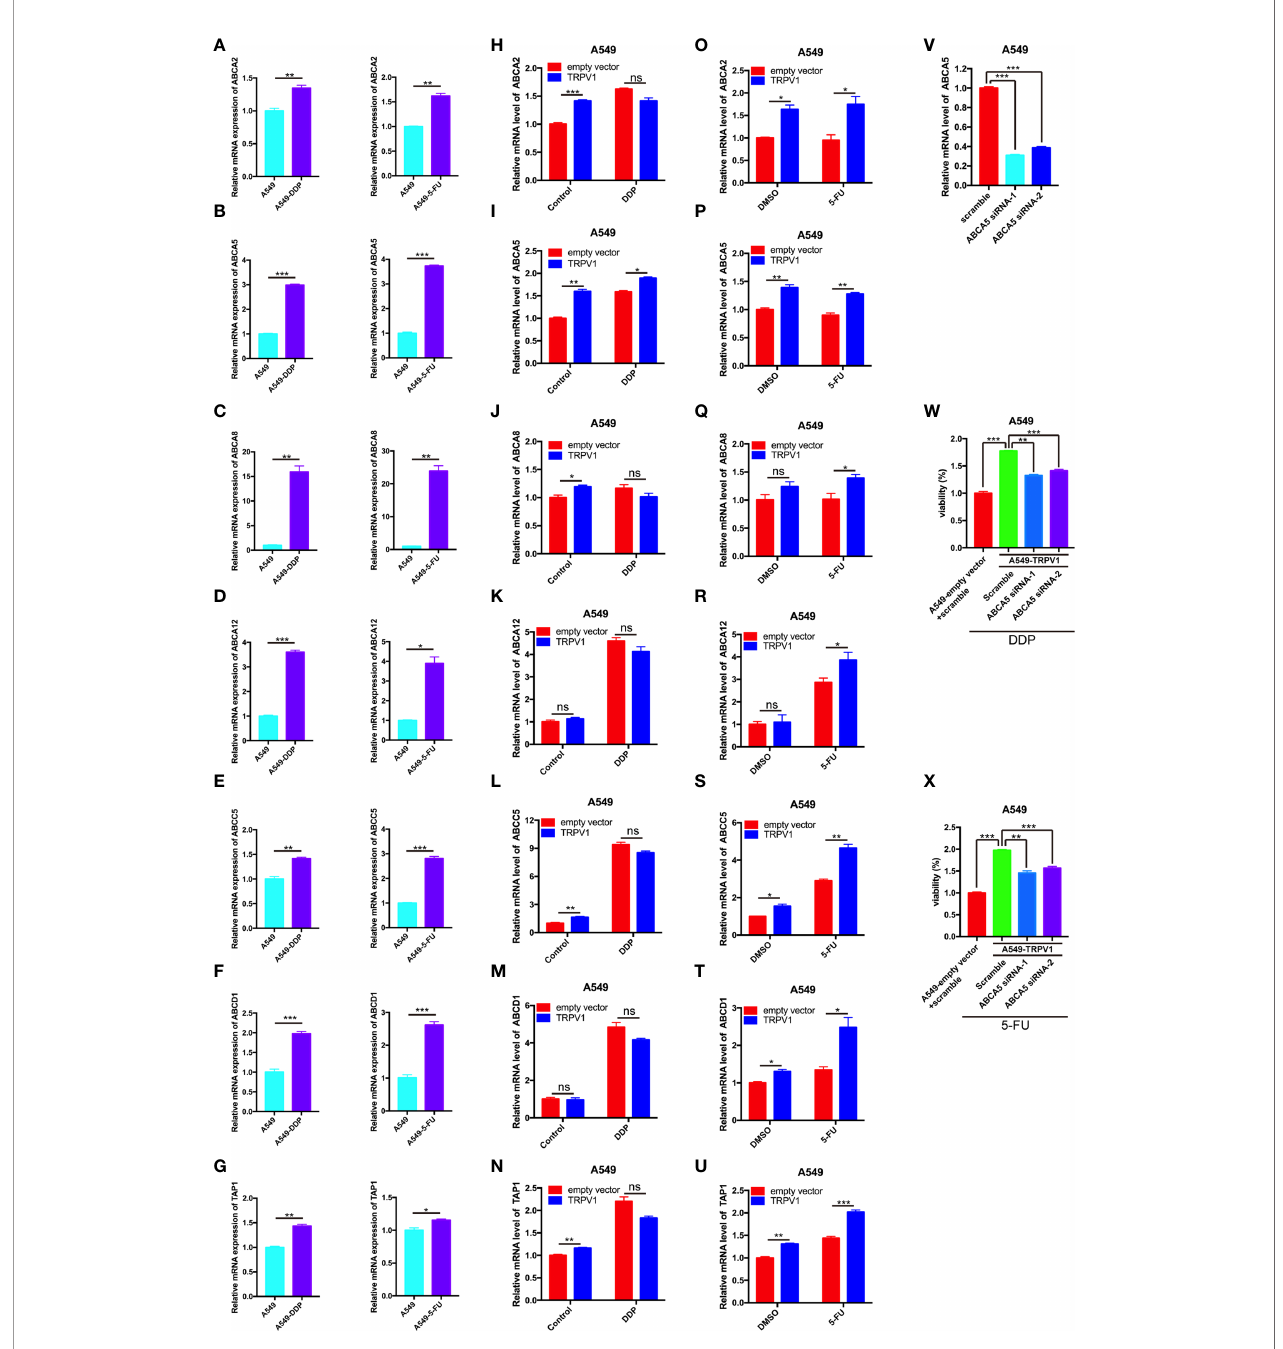
FIGURE 5 | TRPV1 promotes DDP/5-FU resistance through upregulation of the expression of ABC drug transporters. (A-G) Quantitative PCR analysis of the expression of ABC transporter genes in A549 cells (azure bars) and A549-DDP/5-FU resistant cells (purple bars). (H-U) Quantitative PCR analysis of the expression of ABC transporter genes in A549 cells transfected with the empty vector (red bars) or stably overexpressing TRPV1 (blue bars) and treated with or without DDP/5- FU. Cells were treated with DDP (1 m M) or 5-FU (0.5 m g/mL) for 24 h. (V) Quantitative PCR analysis of ABCA5 knockdown ef fi ciency. (W) CCK-8 assay of the effect of ABCA5 knockdown on DDP resistance induced by TRPV1 overexpression. ABCA5 knockdown partially reversed DDP resistance induced by TRPV1 overexpression. Cells were treated with 1.25 m M DDP for 72 h. (X) CCK-8 assay of the effect of ABCA5 knockdown on 5-FU resistance induced by TRPV1 overexpression. ABCA5 knockdown partially reversed 5-FU resistance induced by TRPV1 overexpression. Cells were treated with 0.3125 m g/mL 5-FU for 72 h. Three independent experiments were performed. Statistical signi fi cance was determined using Student ’ s t test. Data represent mean ± SEM. * P < 0.05. ** P < 0.01. *** P < 0.001. ns, not statistically signi fi